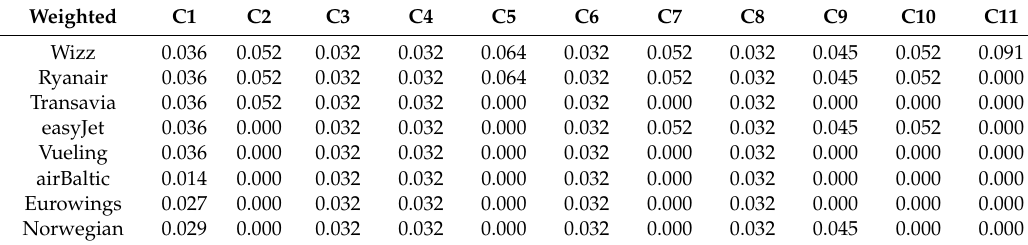
Table A3. Full calculations of the LCC criteria TOPSIS.